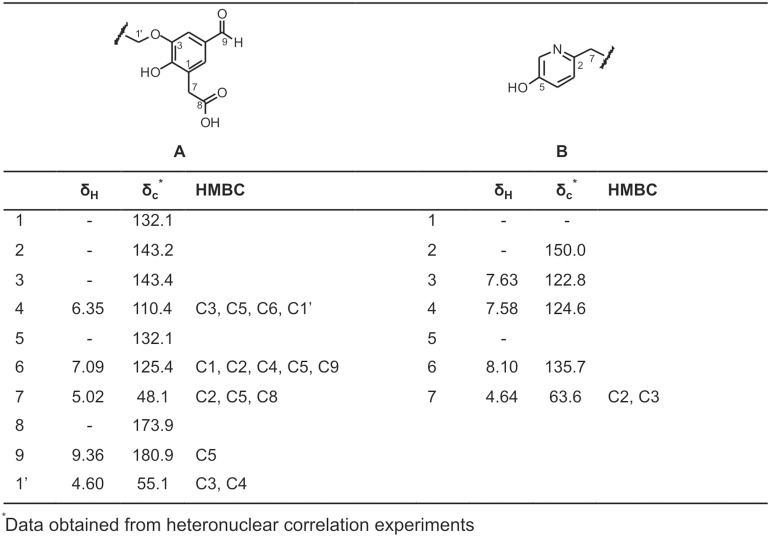

1H, 13C NMR data and HMBC correlations of metabolites A and B.